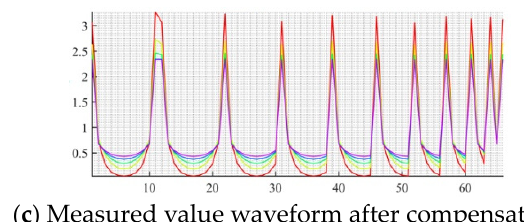
Figure 6. Waveforms of measured values before and after annular flow compensation.